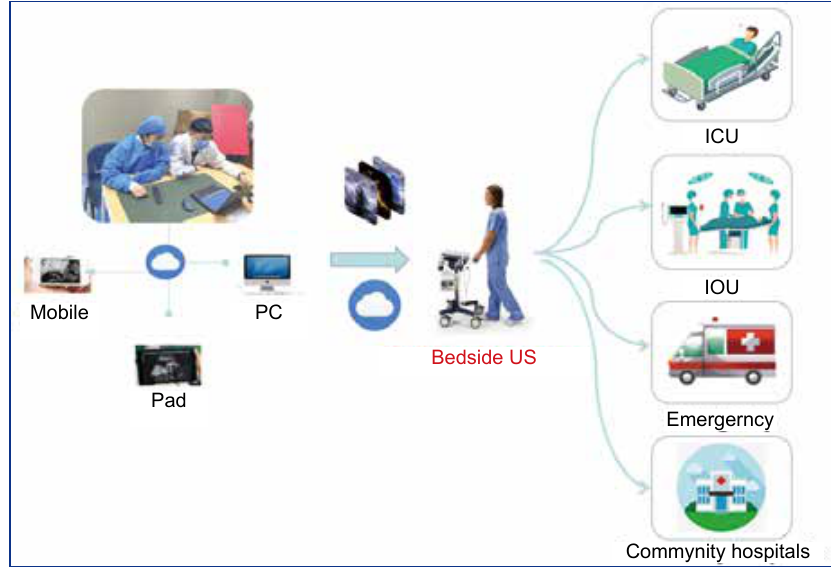
Figure 7 Workflow of “one-to-many” mode: one expert team deals with multiple scenarios, which can exploit the expert’s knowledge to the greatest extent and improve the healthcare in areas with poor quality medical resources. (PC, personal computer; ICU, intensive care unit; IOU, intraoperative